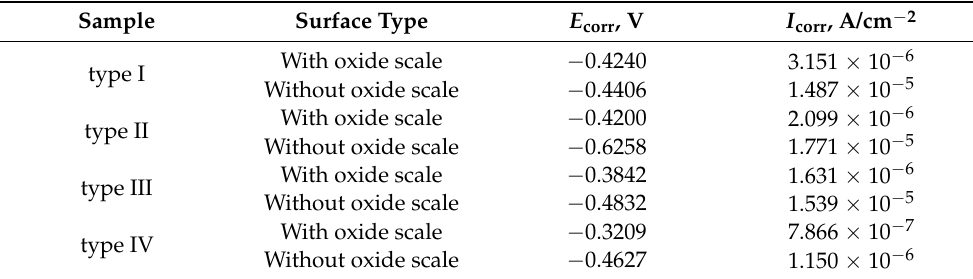
Table 5. Corrosion potential ( E corr ) and current ( I corr ) of samples with different oxide scales.